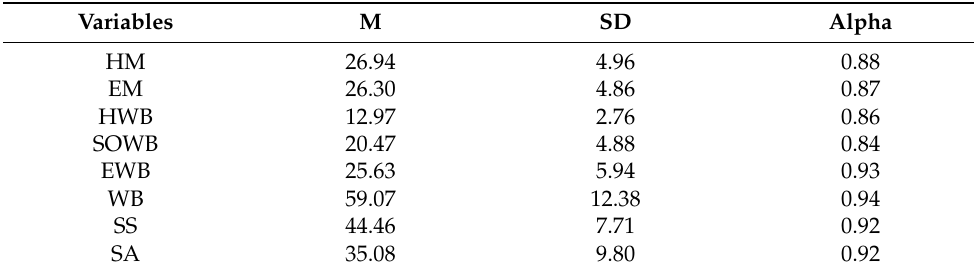
Table 3. Mean, SD and alpha of the variables.